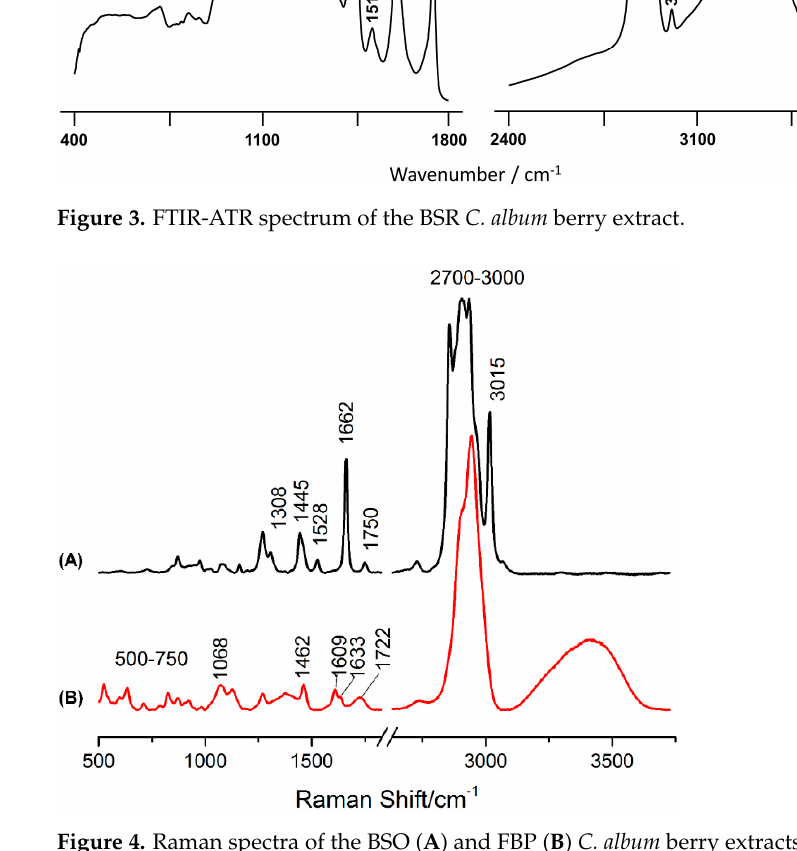
Figure 4. Raman spectra of the BSO ( A ) and FBP ( B ) C. album berry extracts.